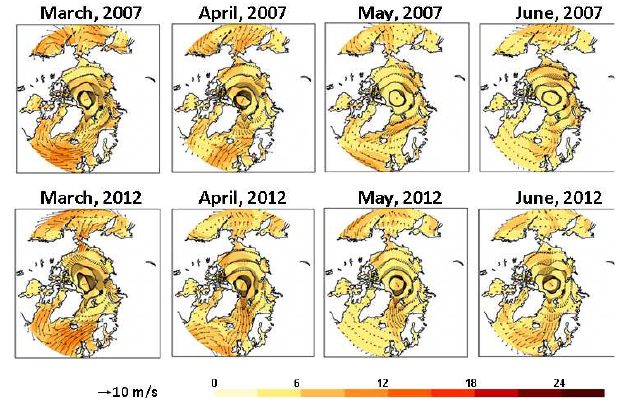
Fig. 8. Near-surface winds (1000hPa) during spring and early sum- Fig. 8: Near-surface winds (1000 hPa) during spring and early summer based on ERA- mer based on ECMWF global atmospheric reanalysis-Interim Re- Interim Reanalysis. The data for June 2012 is from the ECMWF forecasts. analysis. The data for June 2012 are from the The European Centre for Medium-Range Weather Forecasts (ECMWF)